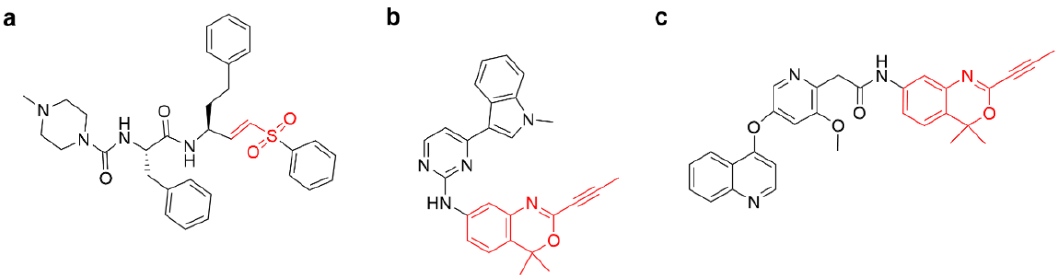
Figure 7. ( a ) Chemical structure of cysteine protease inhibitors. ( b ) Alkynyl benzoxazine ‐ based JAK3 covalent inhibitor. ( c ) Alkynyl benzoxazine ‐ based c ‐ KIT covalent inhibitor.